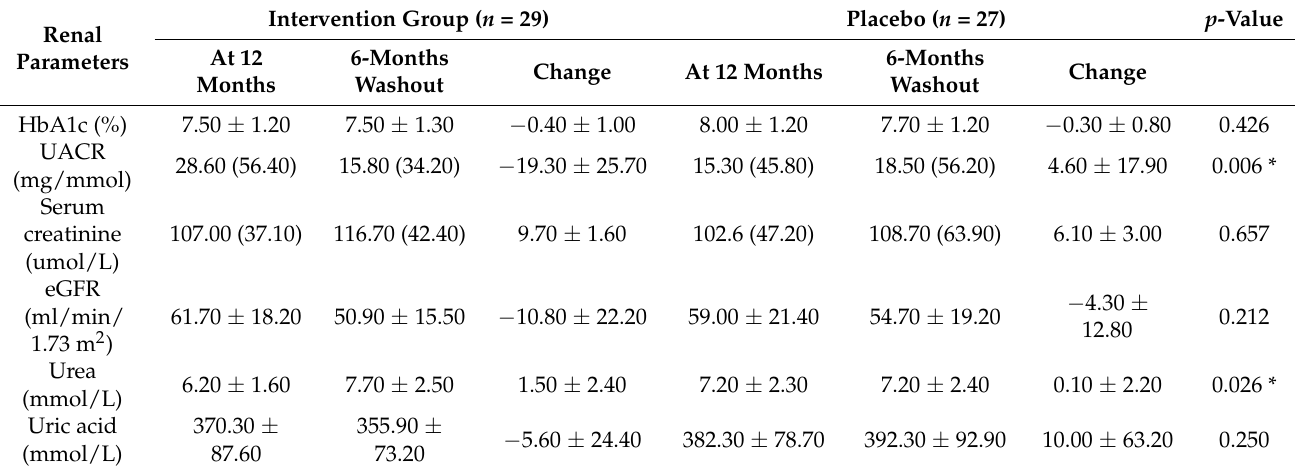
Table 7. Renal parameters at 12 months Tocovid supplementation and at 6 months post washout between intervention and placebo